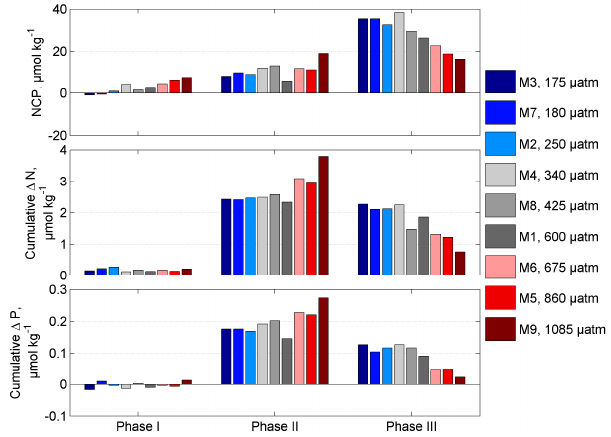
Figure 6 Fig. 6. Net community production, cumulative change in inor- ganic nitrogen ( 1 N) and cumulative change in inorganic phospho- rus ( 1 P) on the last day of every experimental phase for 9 meso-